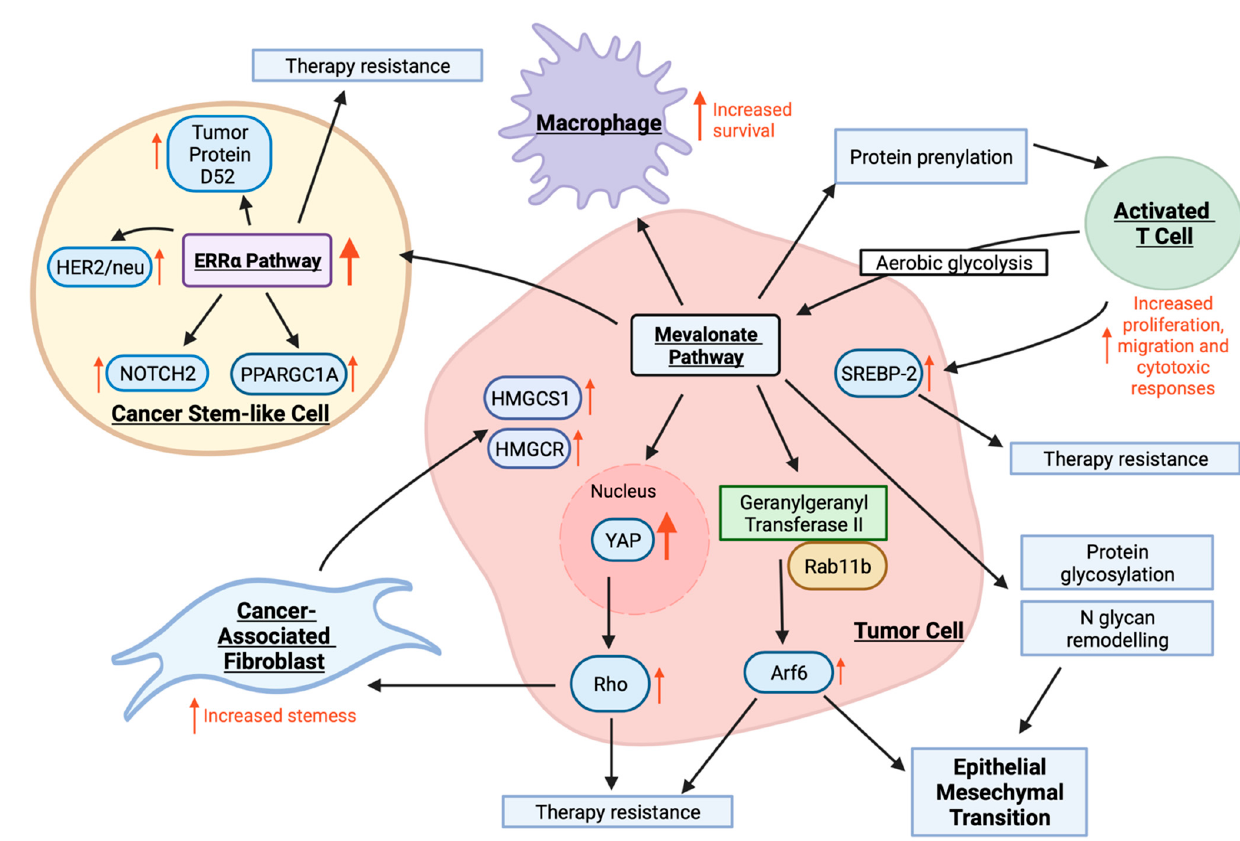
Figure 3. The pleiotropic effects of tumor cells, cancer stem-like cells (CSCs), cancer-associated fibroblasts (CAFs) and immune cells within the tumor microenvironment. The mevalonate (MVA) pathway upregulation in tumor cells contributes to increased protein prenylation and activation of GTPases, including Rho, and increased Hippo pathway activity, specifically YAP. MVA pathway activity, as well as Rho and YAP, contribute to epithelial to mesenchymal transition of tumor cells and therapy resistance. MVA pathway upregulation activates the ERR α pathway in CSCs, which in turn stimulates multiple proto-oncogenes, enhancing the propagation of CSCs and promoting therapy resistance. Rho activation increases stemness of CAFs, which also contribute to increased HMG-CoA synthase 1 (HMGCS1) and HMG-CoA reductase (HMGCR) expression, sustaining increased MVA pathway expression. Upregulated MVA signaling also alters immune cell function by stimulating T-cells’ shift to aerobic glycolysis, fueling MVA metabolism as well as increased SREBP-2 activity. The non-sterol branch of the MVA pathway is also implicated in increasing T-cell proliferation, migration and cytotoxic responses. Macrophage survival is also promoted in a Rac-1-dependent manner. Together, the various cell types within the tumor microenvironment contribute to the promotion of tumorigenesis.